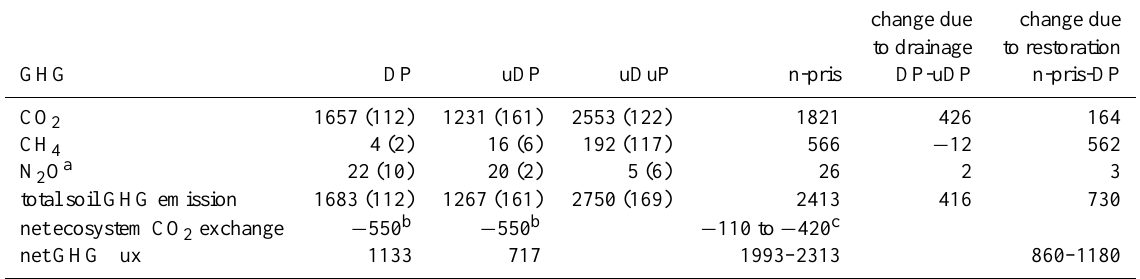
Table 4. Estimated net GHG fluxes in gCO 2 em − 2 yr − 1 , mean of 2008 and 2009, for each treatment at Flanders Moss and change due to drainage and restoration. Values between brackets indicate the standard error of mean of the replicated blocks.